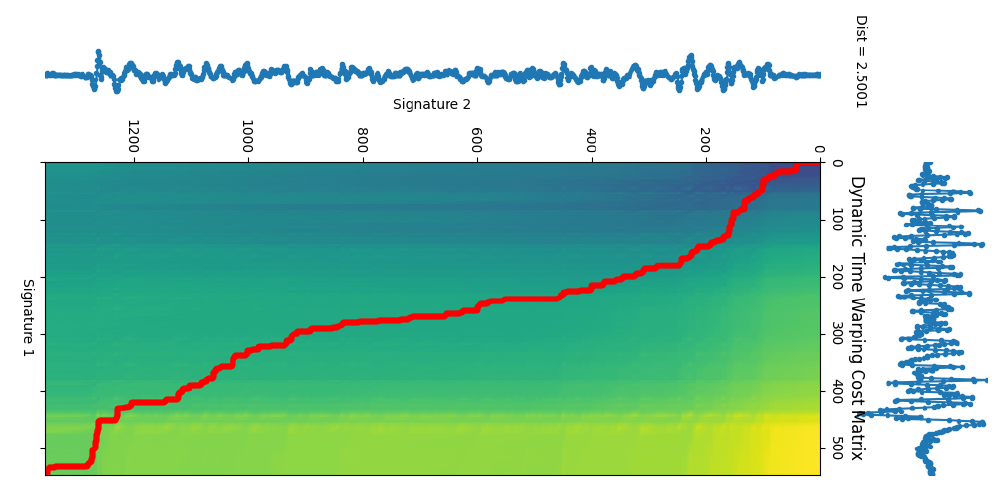
Figure 4. Dynamic time warping cost matrix of two signature signals.